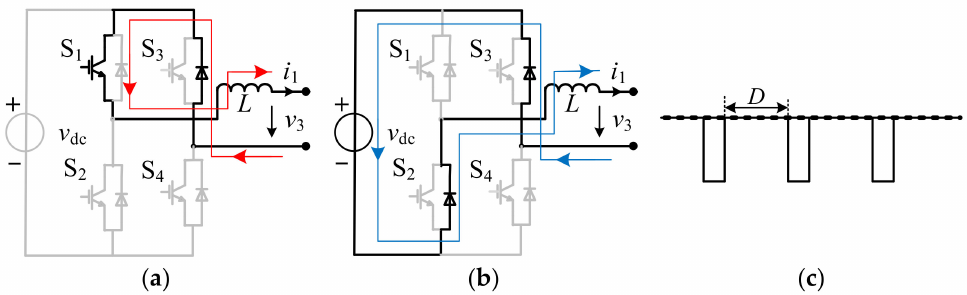
Figure 5. CCD state analysis: ( a ) current path when S 1 is on; ( b ) current path when S 1 is off; and ( c ) output